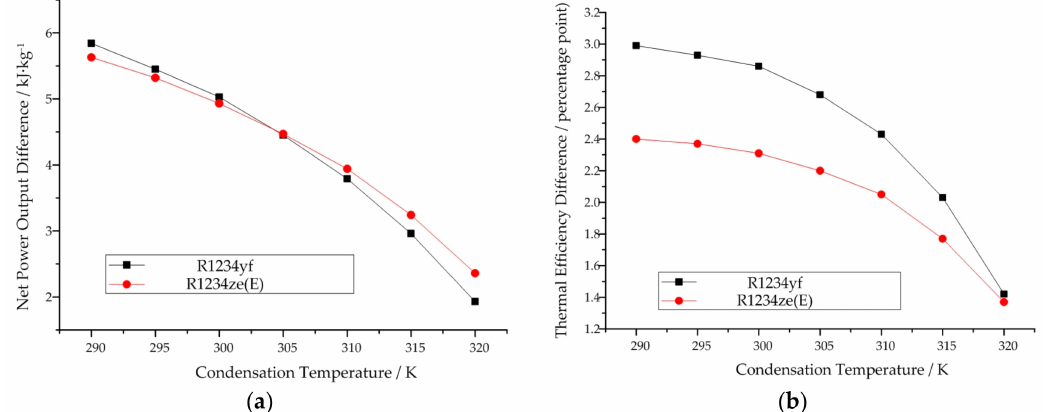
Figure 12. Thermodynamic performance di ff erence variation between subcritical and transcritical cycle with increase of condensation temperature: ( a ) Net power output, ( b )Thermal e ffi ciency.